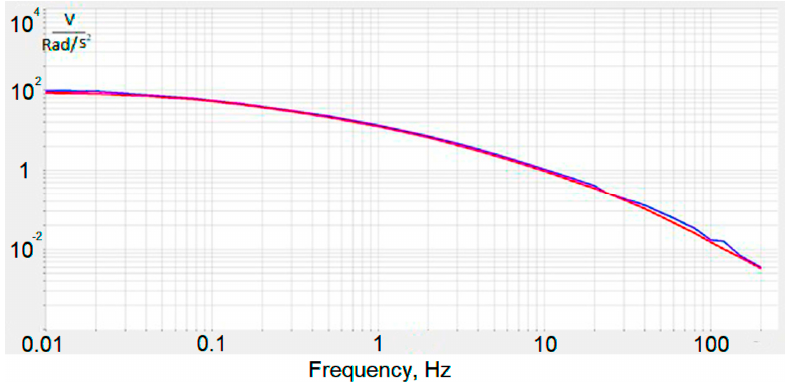
Figure 8. Amplitude-frequency characteristic from the first stage of amplification, obtained on a calibration bench (blue curve) and using MHD cells (red curve).